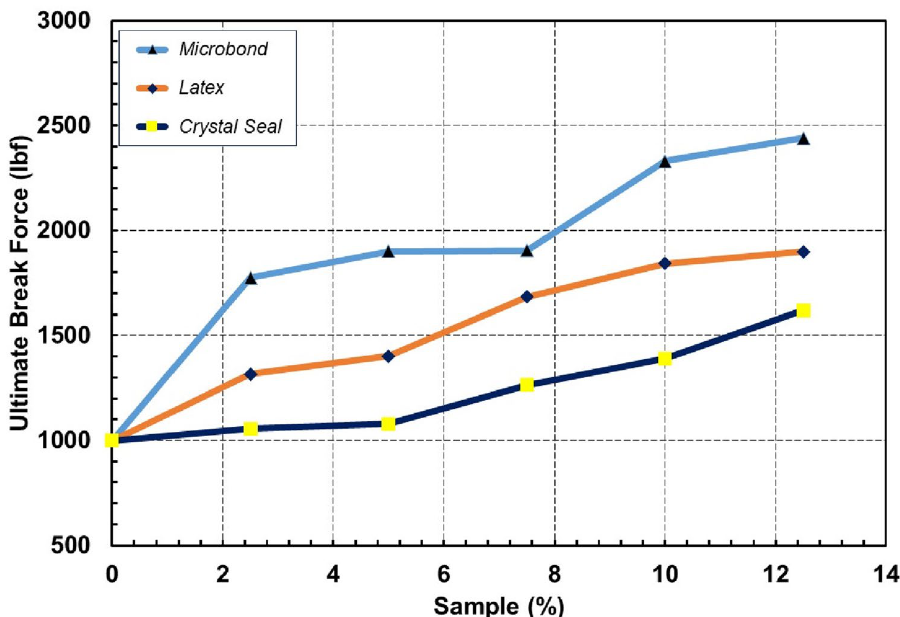
Fig. 16 Additives comparison, ultimate break